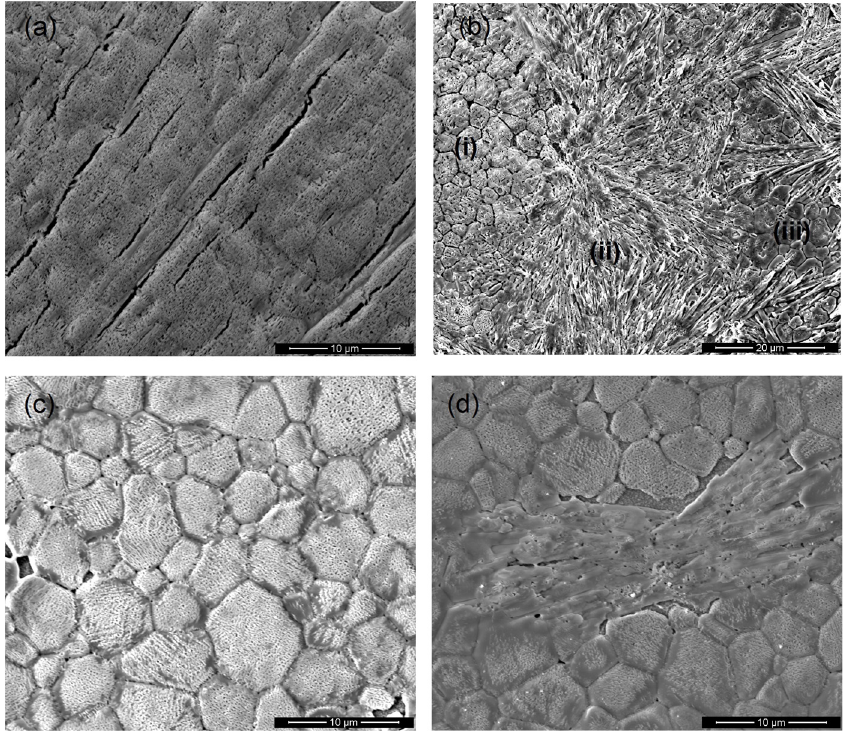
Figure 7. SEM images of the treated perovskite 50-day films fabricated via spray deposition at 120 °C and annealed for: a) 5 s; b) 20 s, showing irreversible PbI